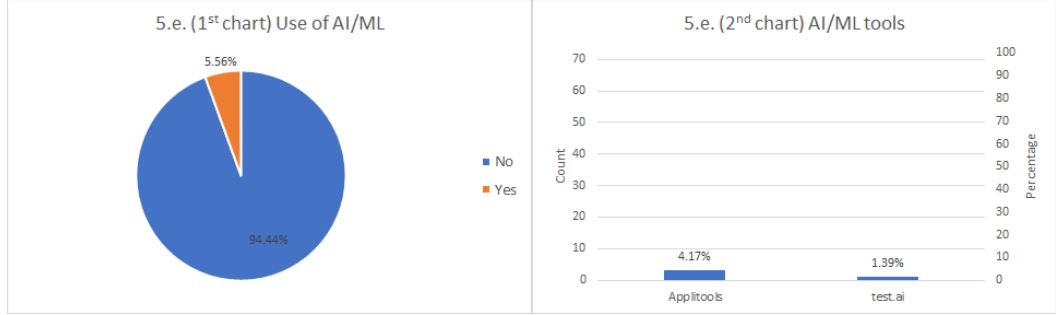
Figure 14. Artificial Intelligence (AI) and Machine Learning (ML) approaches used with